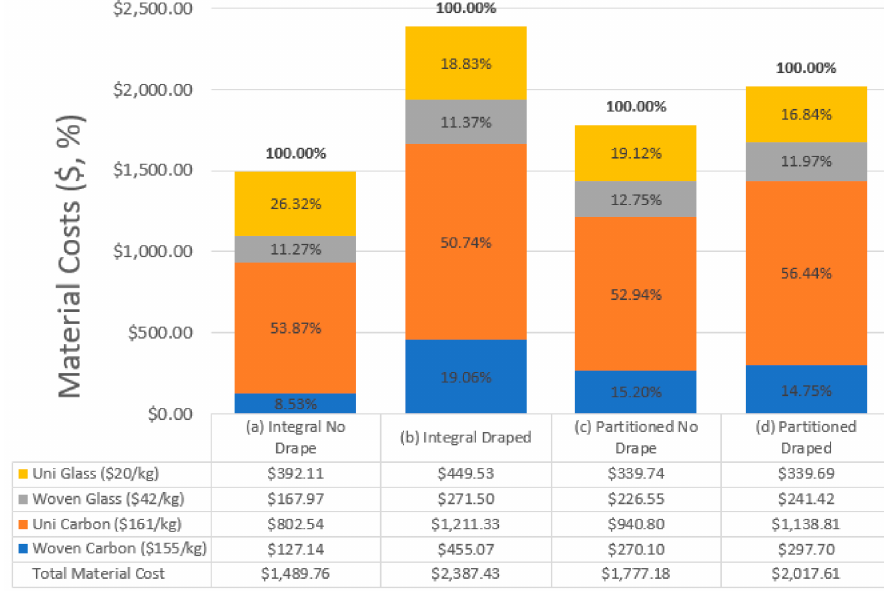
Figure 13. Comparison of structural cost by material type for the four